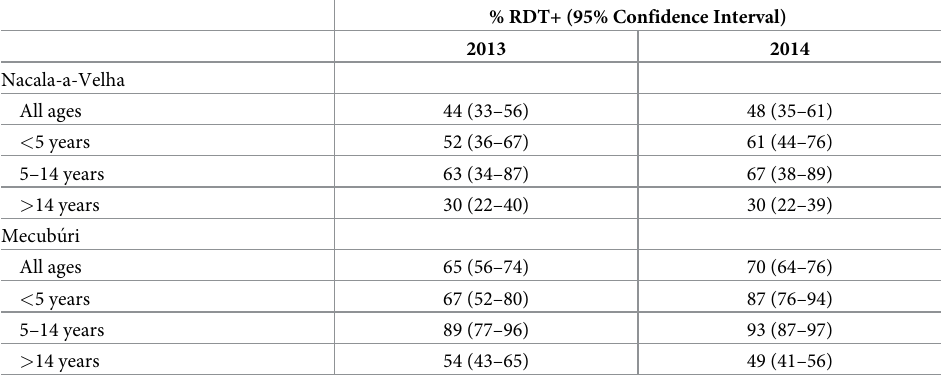
Table 3. Prevalence of P . falciparum infection as assessed by RDT immediately following and one year after an LLIN distribution campaign in Nacala-a-Velha and Mecubu´ri Districts,